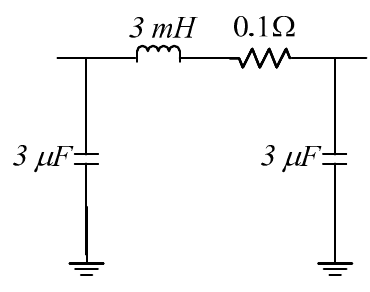
Figure 14. Cable model for the simulation.